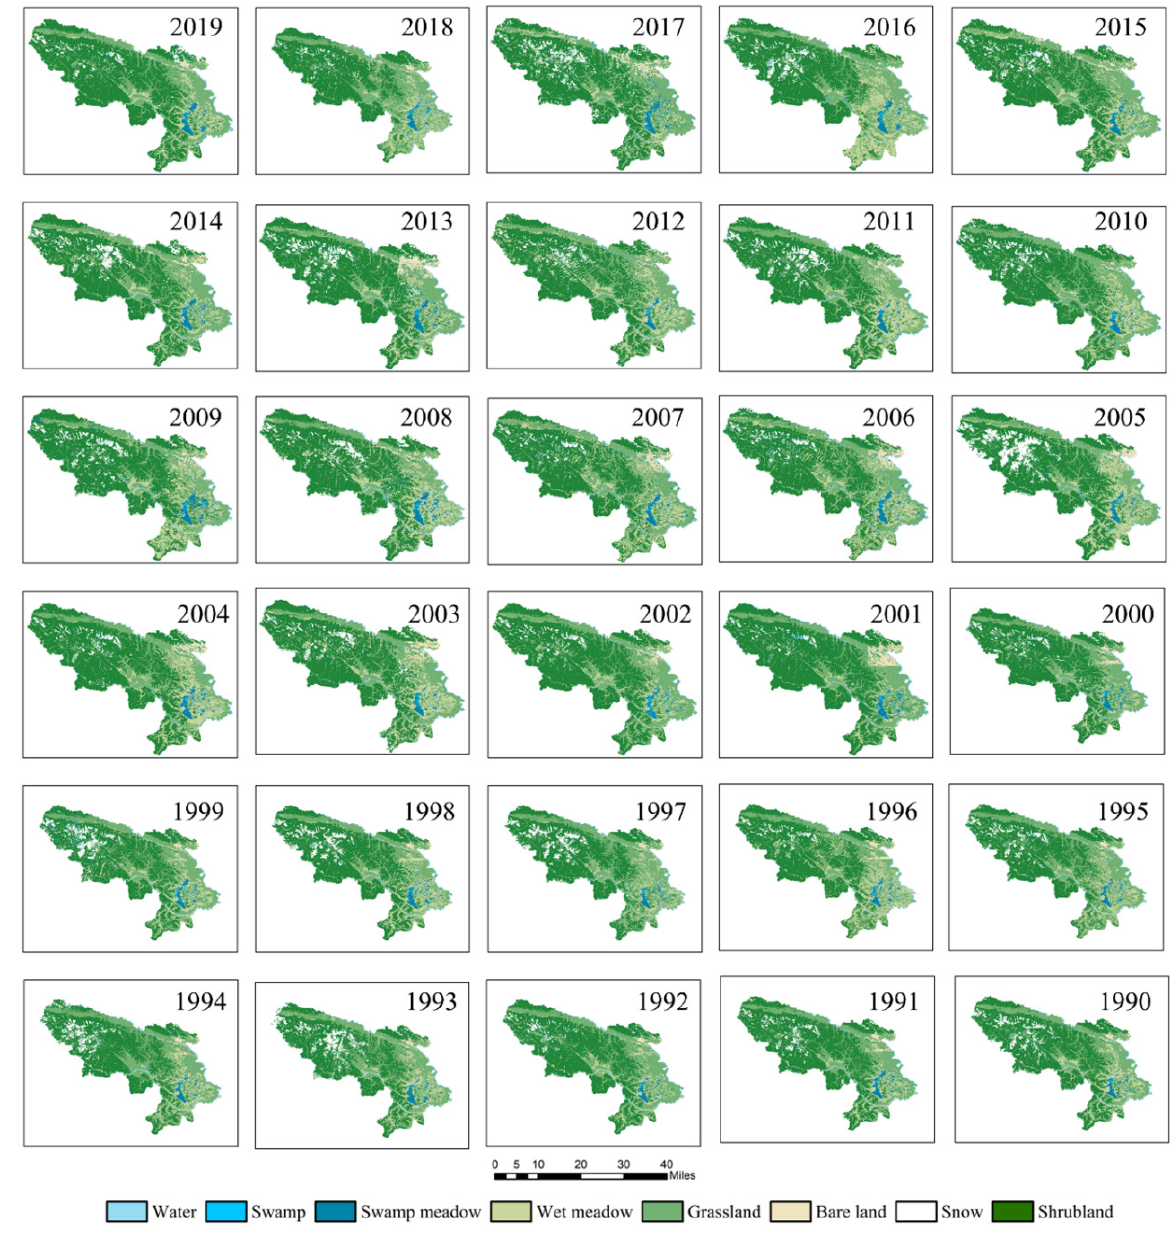
Figure 6. Maqu wetland classification maps from 1990 to 2019.